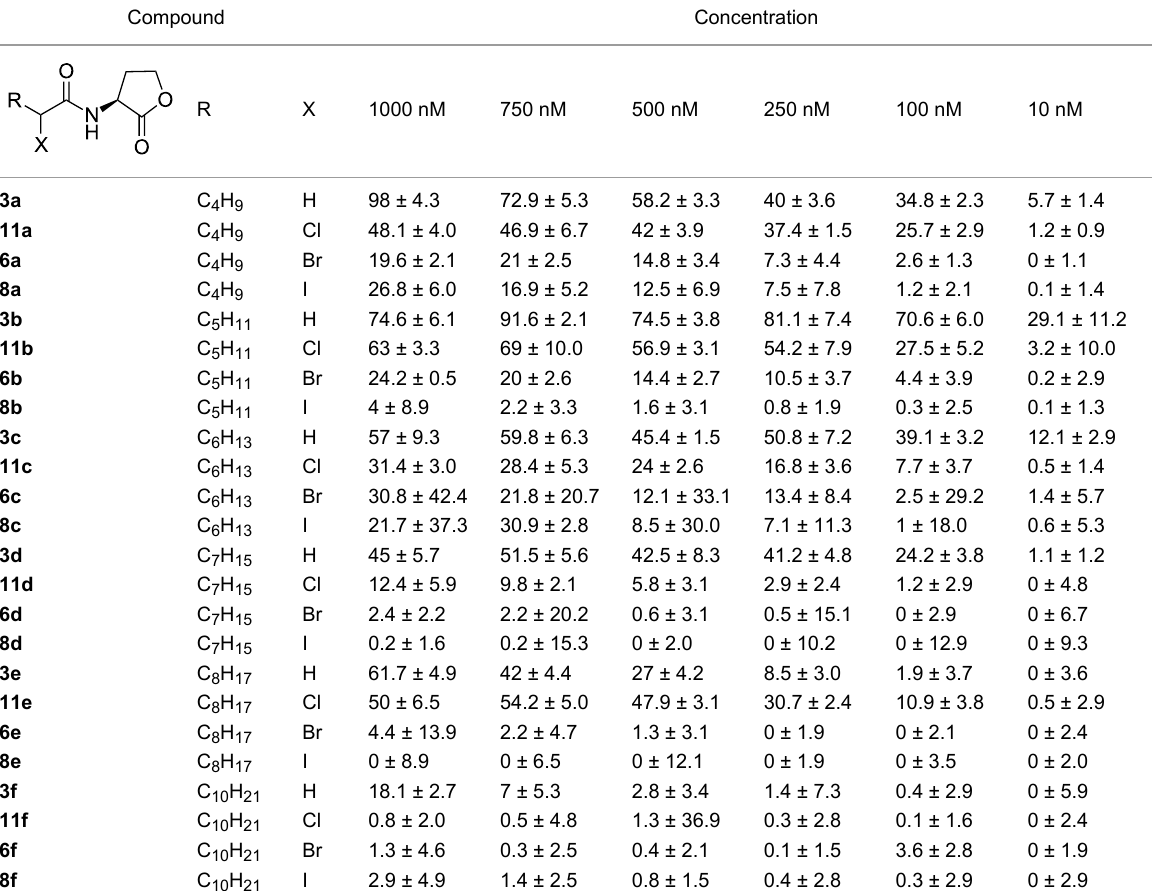
Table 1: Quorum sensing-regulated GFP production by Escherichia coli JB523 induced by natural AHLs 3 and α -haloacylated analogues 6 , 8 and 11 a .